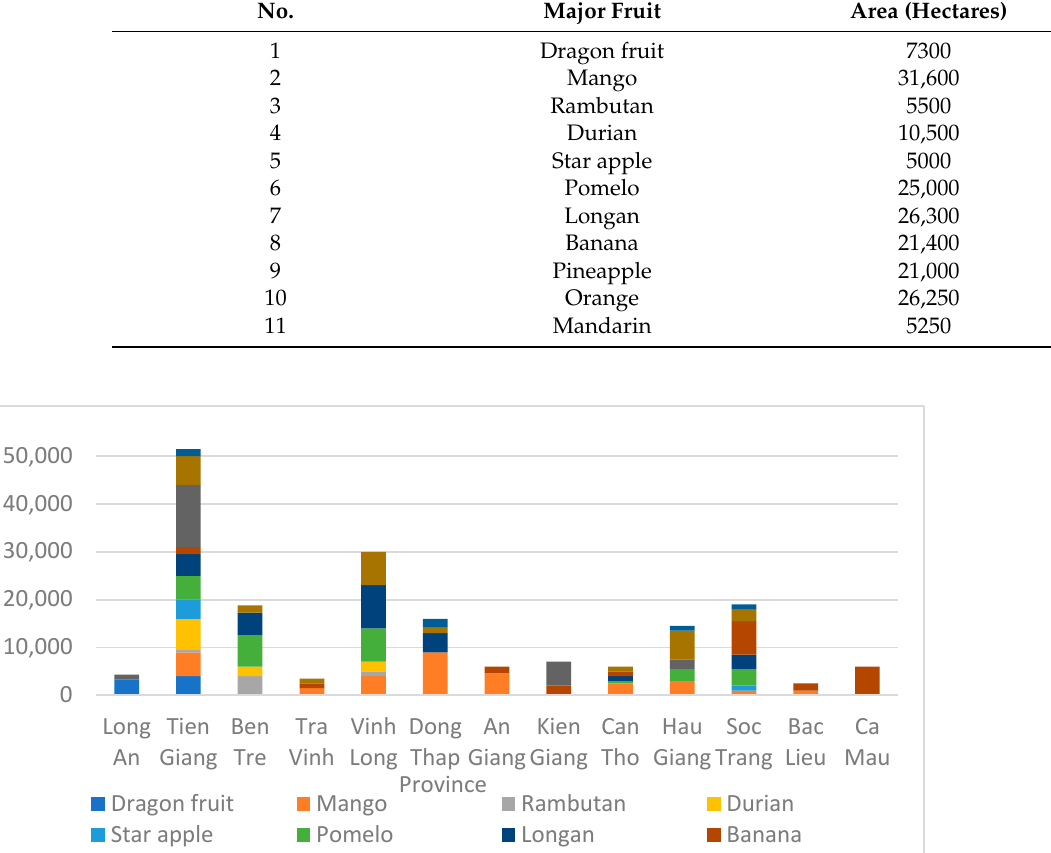
Figure 3. Cultivation planned distribution by province.